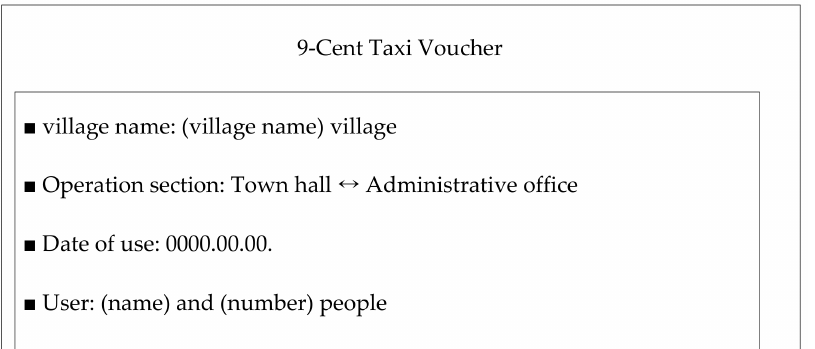
Figure 1. 9-Cent taxi voucher [26].